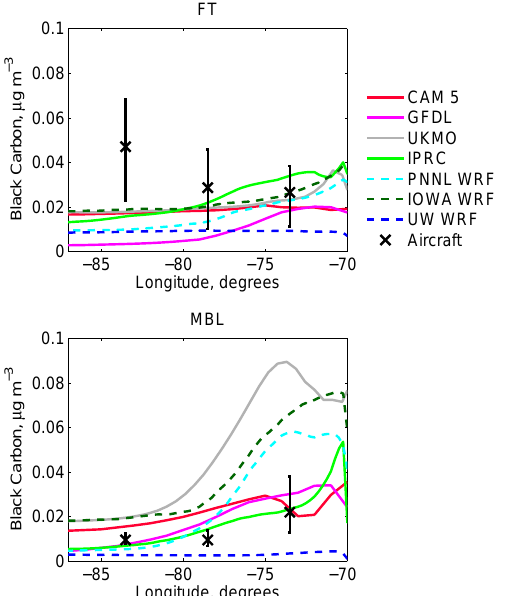
Figure 16. Ozone concentration (ppbv) compared along 20 ◦ S with C-130 and BAe-146 aircraft